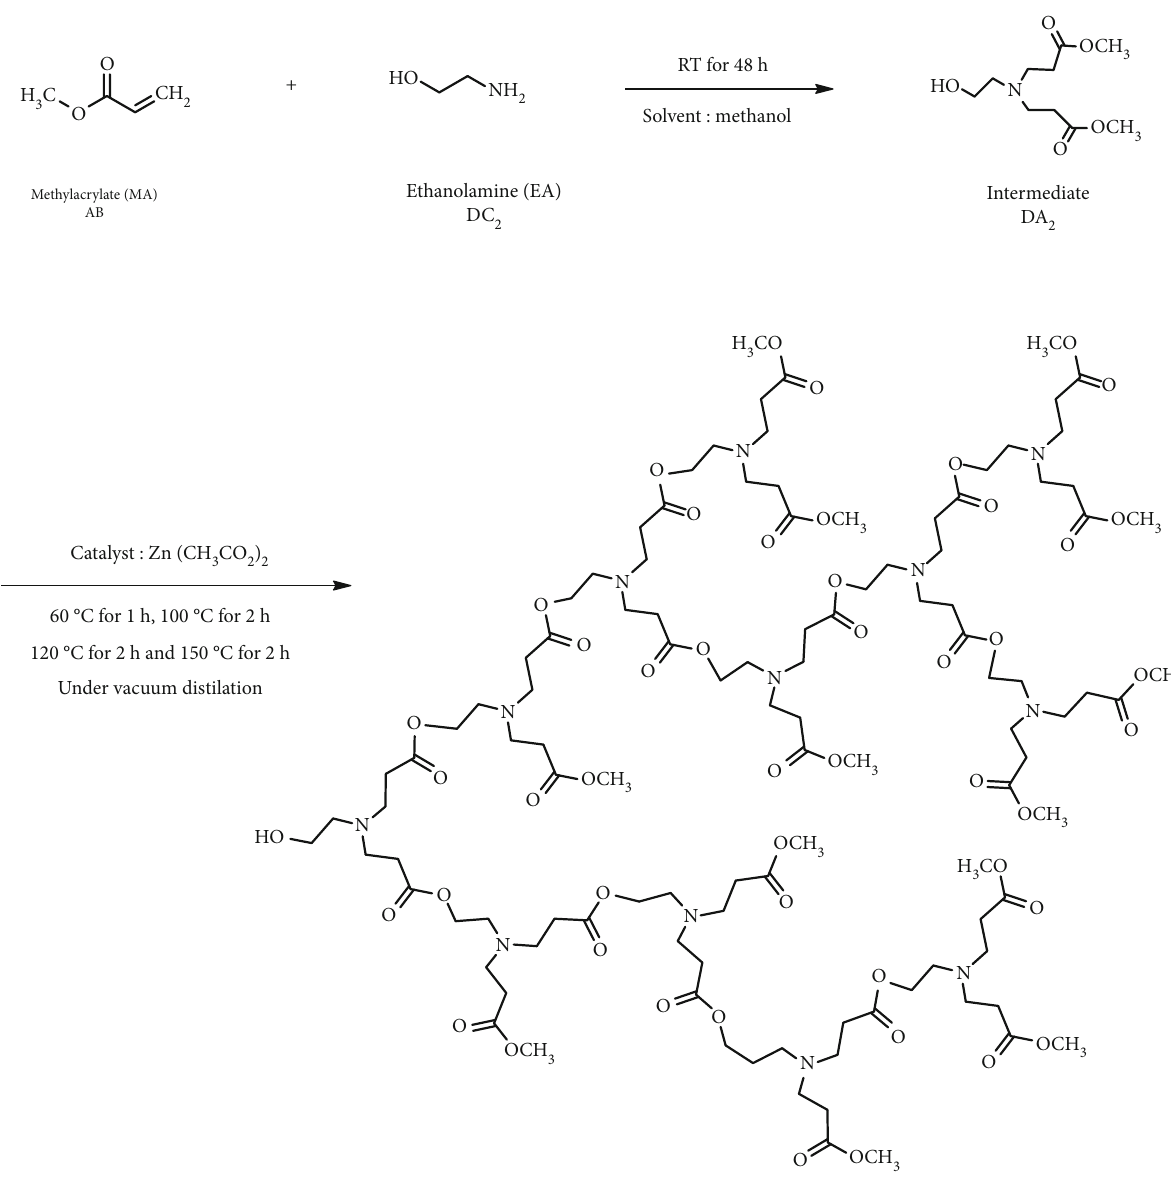
Scheme 2: Synthetic route of hyperbranched poly(MA-EA)